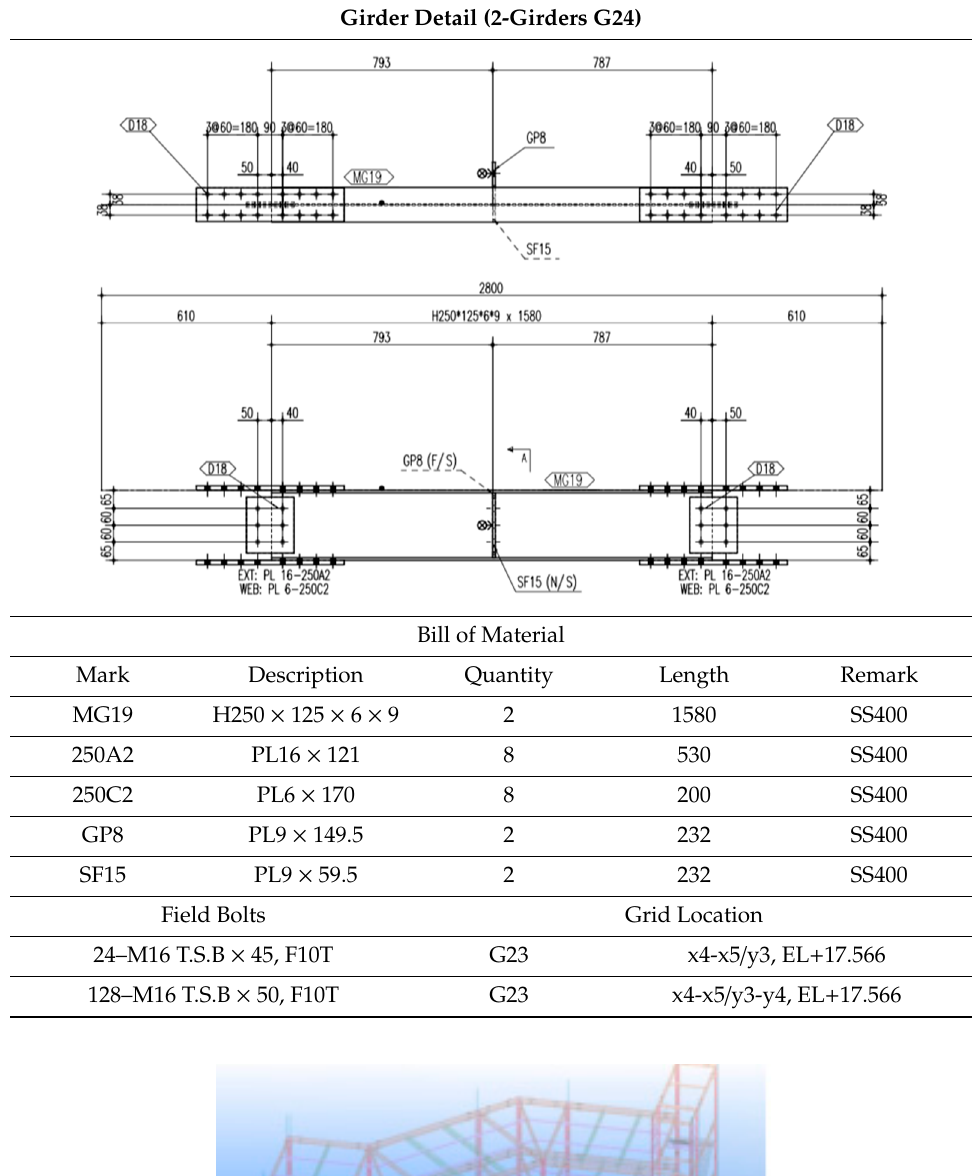
Table 9. Prefabrication review of beams.